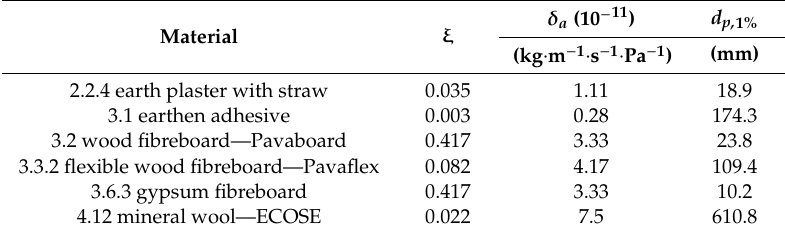
Table 3. Theoretical moisture penetration depth values.